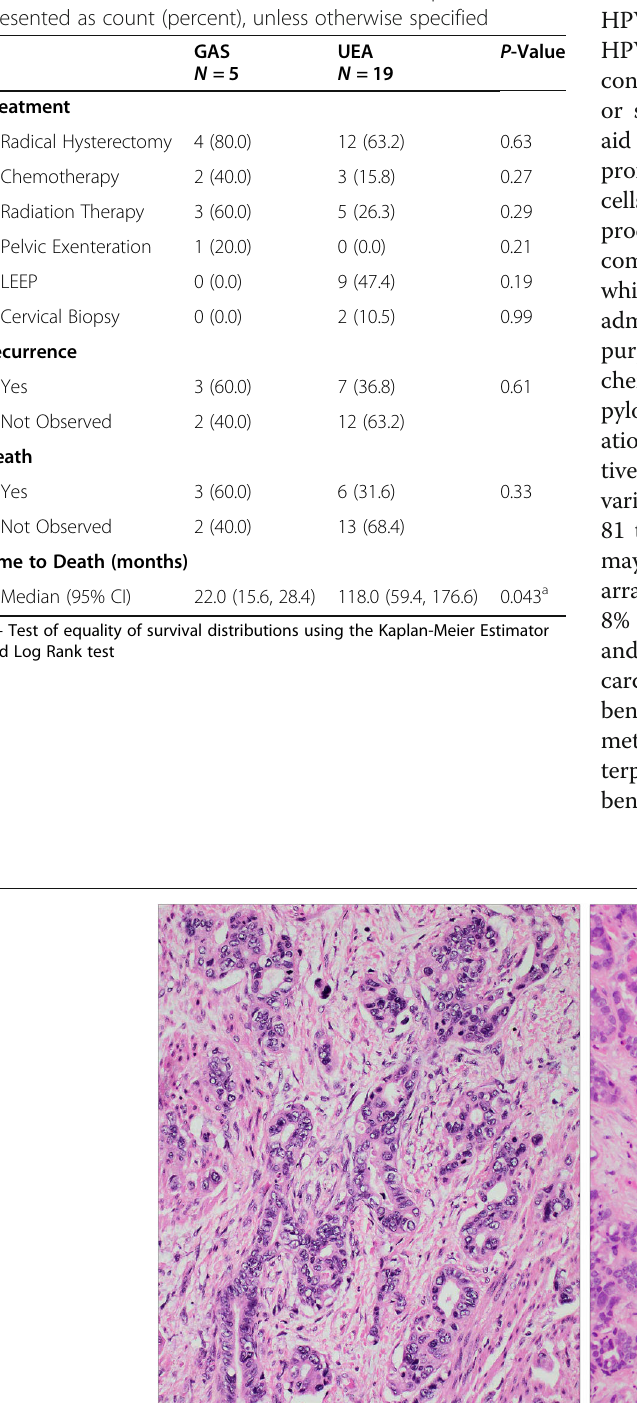
Fig. 3 Primary tumor was composed mostly of irregular glands, nests of cells, and occasional invasive single cells. The nuclei varied in size and shape and there was prominent variation from vesicular to highly hyperchromatic nuclei. Nucleoli were present in many cells, but not in all. Occasional goblet cells were also present. Mitotic figures and apoptotic bodies were frequent. Hypocellular and edematous stroma was dominant in many areas of the tumor. The morphology is nearly identical in the primary tumor ( A ) and metastasis in skin ( B ) a year after the